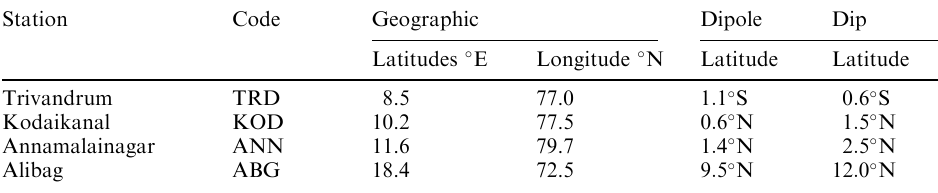
Table 1. List of stations whose Station Code data is utilized in the present study